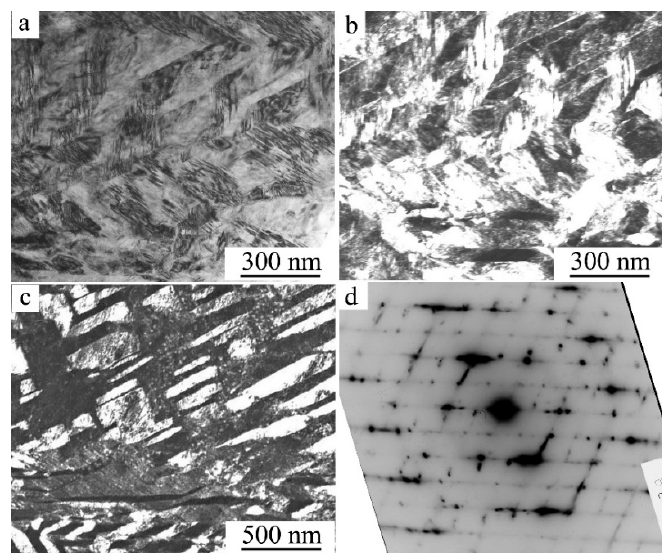
Figure 9. TEM images of the microstructure of the alloy Ni 50 Ti 32 Hf 18 ( a ) bright field and ( b , c ) dark-field images and ( d ) correspondent SAED.